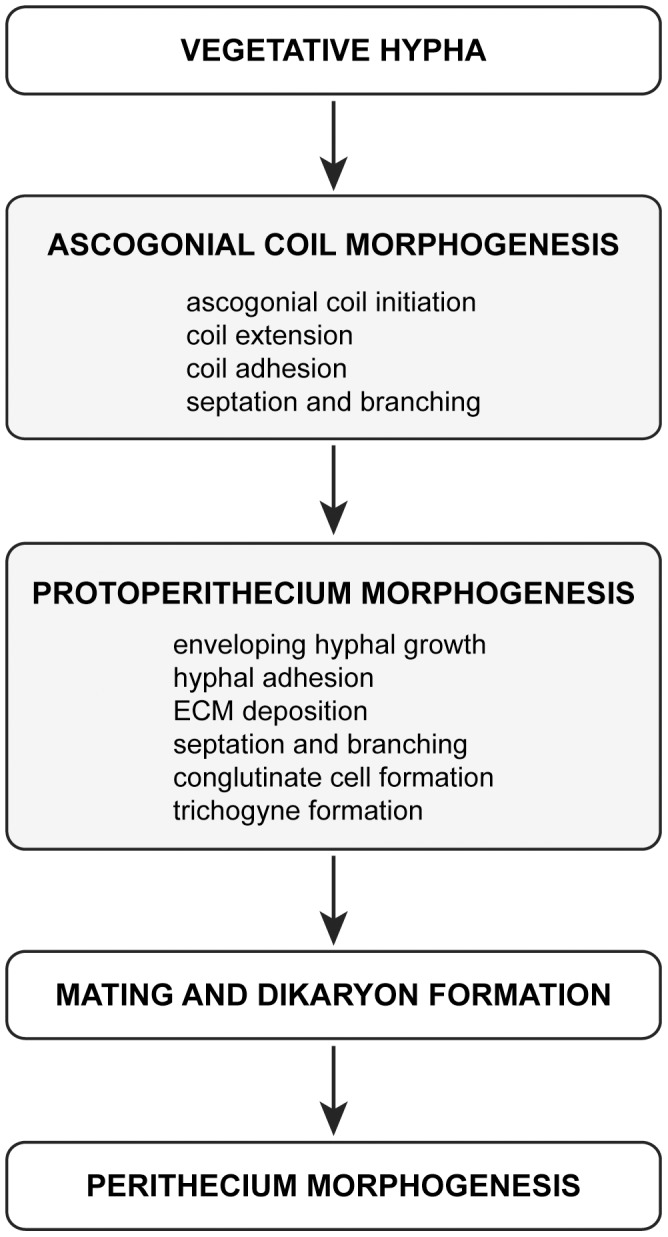
Main stages of protoperithecial development.The ascogonium forms as a specialized, coiled, hyphal branch from a ‘parent hypha’ of the vegetative mycelium. The coil expands, adheres to itself, septates and branches. It sends out more branches, which envelop it. Additional, enveloping hyphae from neighboring areas of the vegetative mycelium, aggregate, reinforce and expand the protective casing around the ascogonium. Secretion of ECM is a precursor to hyphal adhesion during this process, which potentially also involves hyphal fusion. Continued fruitbody expansion, cellular differentiation through septation, branching and cell conglutination (conglutinate cells are those that have adhered to each other), melanization and emergence of the trichogyne mark the final stages of protoperithecium maturation. Mating-cell fusion leading to fertilization and dikaryon formation mark the transition into perithecial development. Autonomous developmental stages of the protoperithecium are highlighted with grey shading. Table 3 summarizes the range of sizes observed for these main developmental stages observed during protoperithecium morphogenesis.